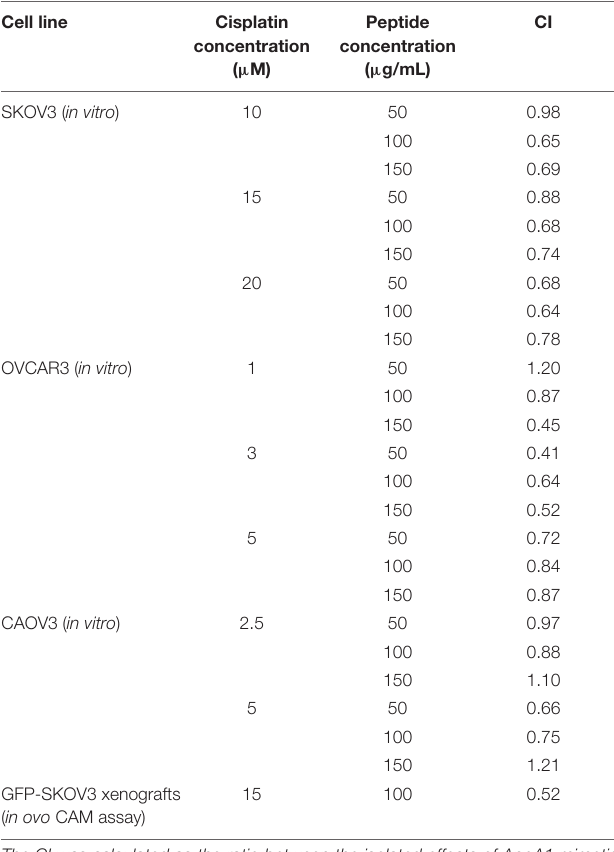
TABLE 1 | Combination index (CI) for cisplatin and the ApoA1 mimetic peptide in vitro and in ovo . Cell